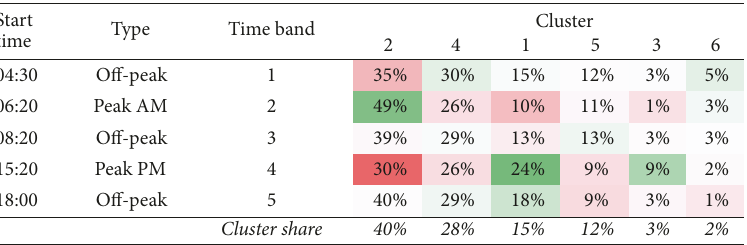
Figure 11: Southbound ØK trains. Cluster share by time band. The color code compares the individual row’s distributions among clusters to the overall distribution among clusters reported in the last row. Clusters sorted by size.